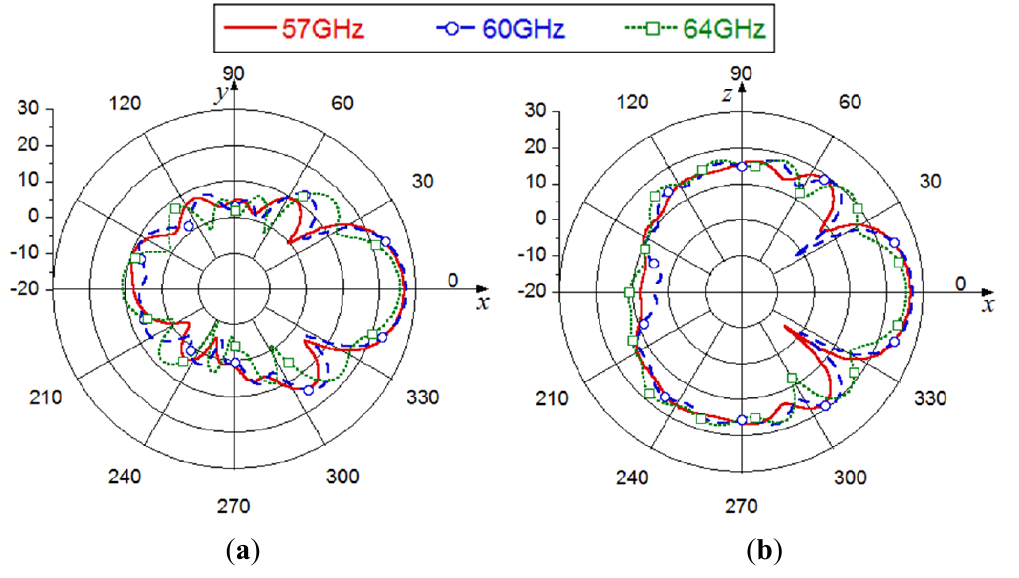
Figure 5. Simulated radiation patterns in free space at 57–60–64 GHz: ( a ) E - and ( b ) H